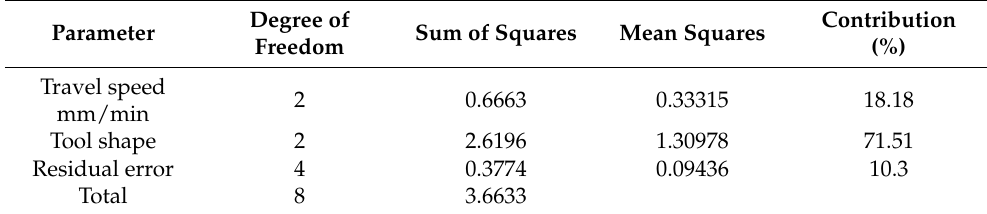
Table 10. ANOVA for Hardness.